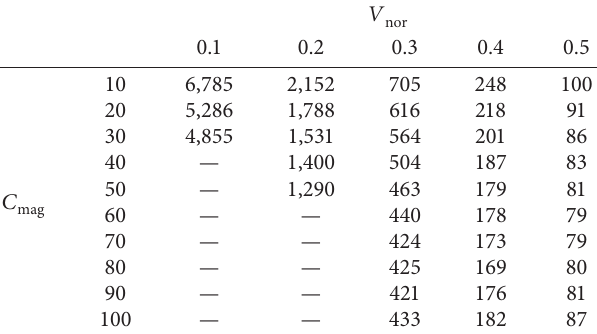
Table 3: Number of rebalancing trades.